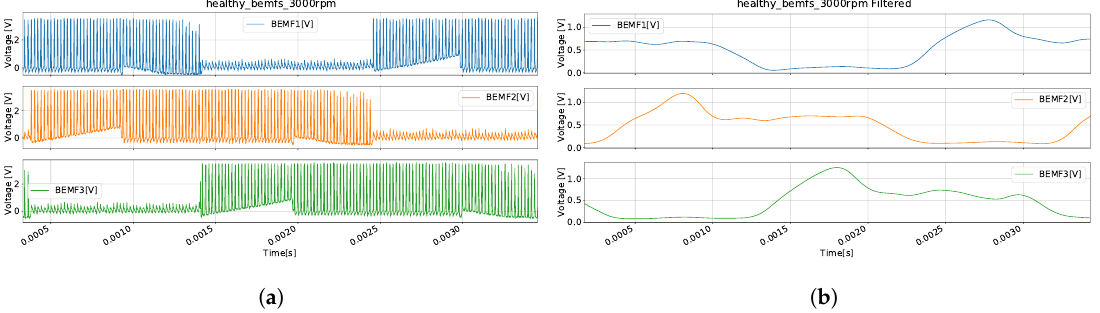
Figure 11. Comparison of the measured phase voltage, before and after the filtering. ( a ) Oscilloscope acquisition—3000 RPM; ( b ) Filtered oscilloscope acquisition—3000